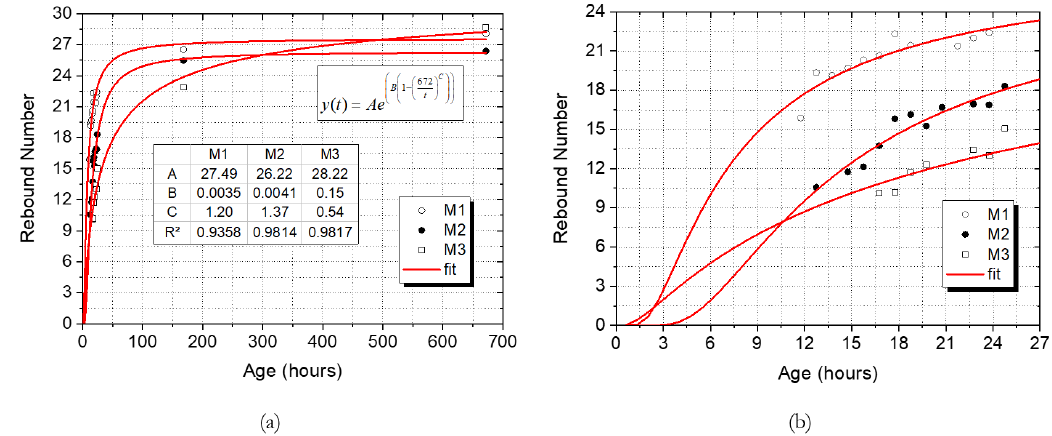
Figure 5 – Variation in the rebound number over age: (a) over 28 days and (b) over 24 hours.